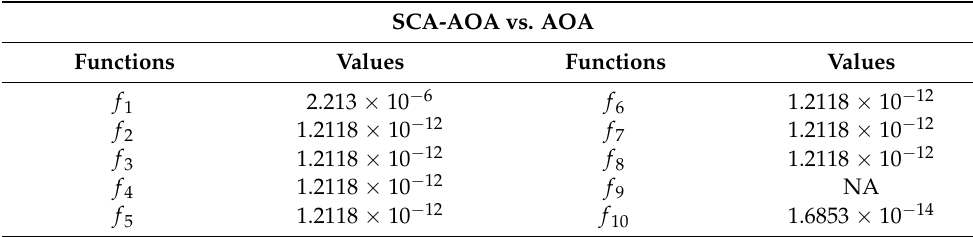
Table 4. p test for pairwise comparison of the SCaAVOA vs. AVOA algorithm.